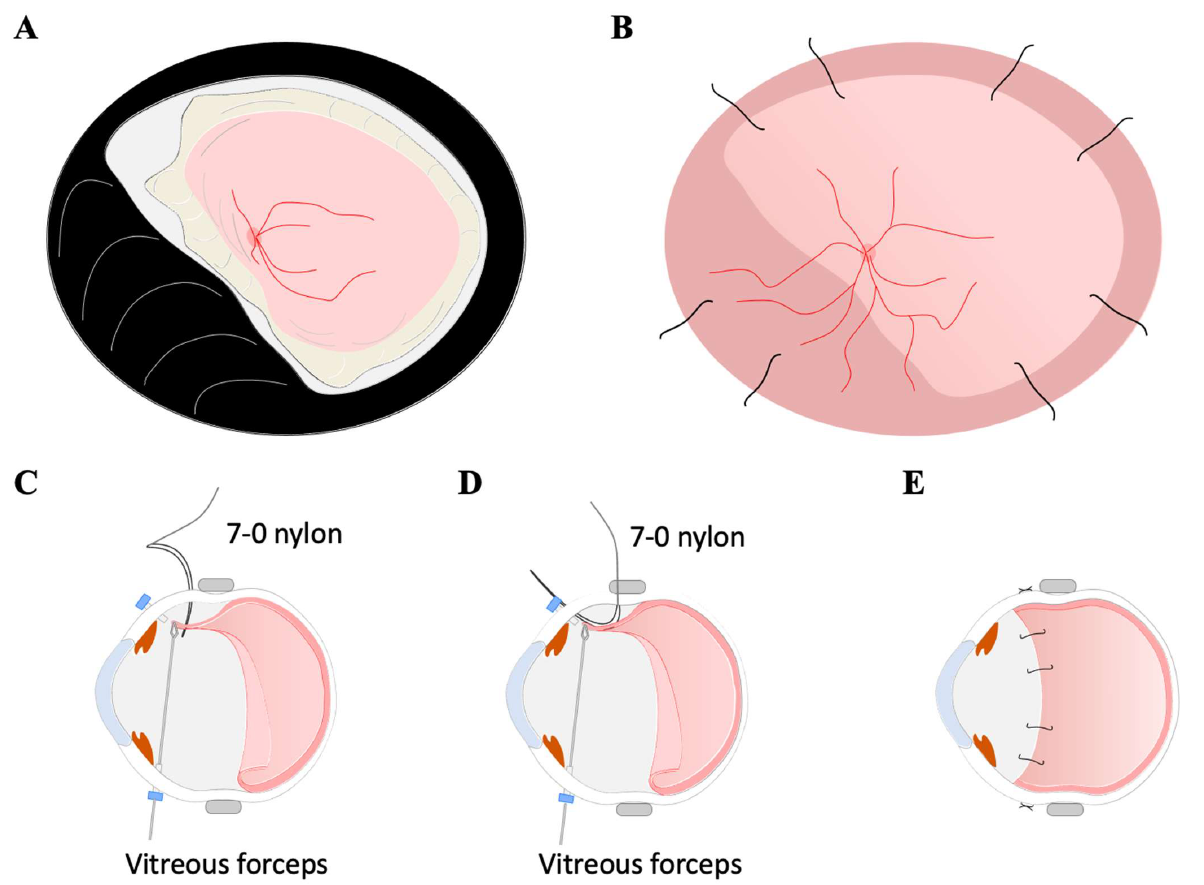
Figure 4. Surgical procedures of the 7-0 nylon single suture technique. Fundus schema before ( A ) and after the repair of the choroidal avulsion ( B ). A 7-0 nylon was introduced into the vitreous cavity at the sclera 6 mm posterior to the limbus ( C ). It was passed through the avulsed choroid by grasping the anterior margin of the avulsed full-thickness choroid to accomplish suturing. The needle was then rotated vertically, and the 7-0 nylon was withdrawn from the sclera at the position of the ciliary body, trying to suture the choroid to the sclera as peripherally as possible ( D ). The 7-0 nylon needle was sutured outside the sclera. The same procedure was performed at two locations in each quadrant ( E ).